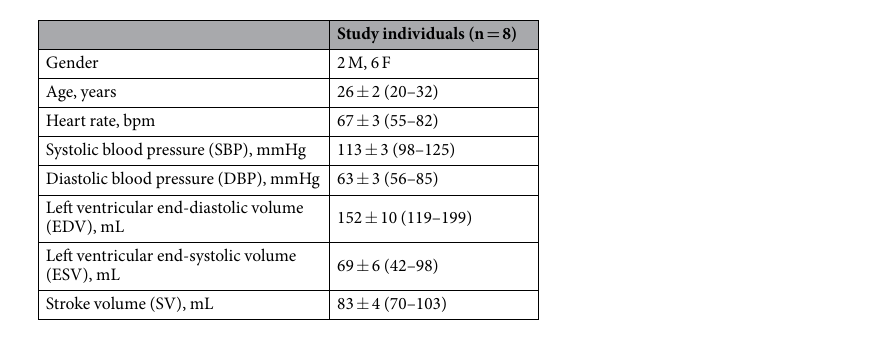
Table 1. Characteristics of the subjects in the study. Values are expressed are mean ± standard error, unless otherwise stated. Ranges are given in